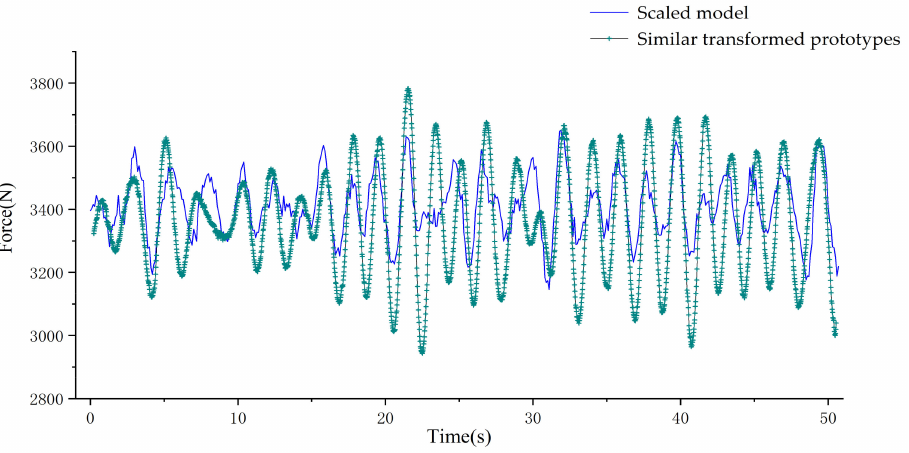
Figure 8. Force contrast diagram at the articulation of upper connecting rod of tower and tensioner